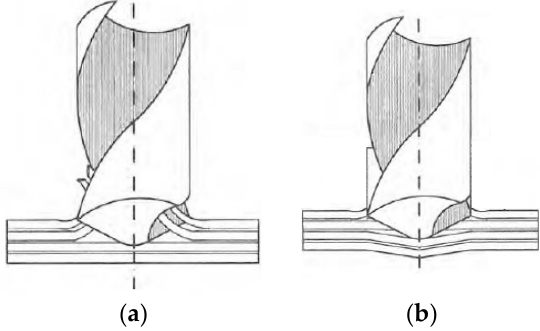
Figure 1. Delaminations caused by drilling: ( a ) ply peeling; ( b ) ply ‘push through’ (adapted from [2]).